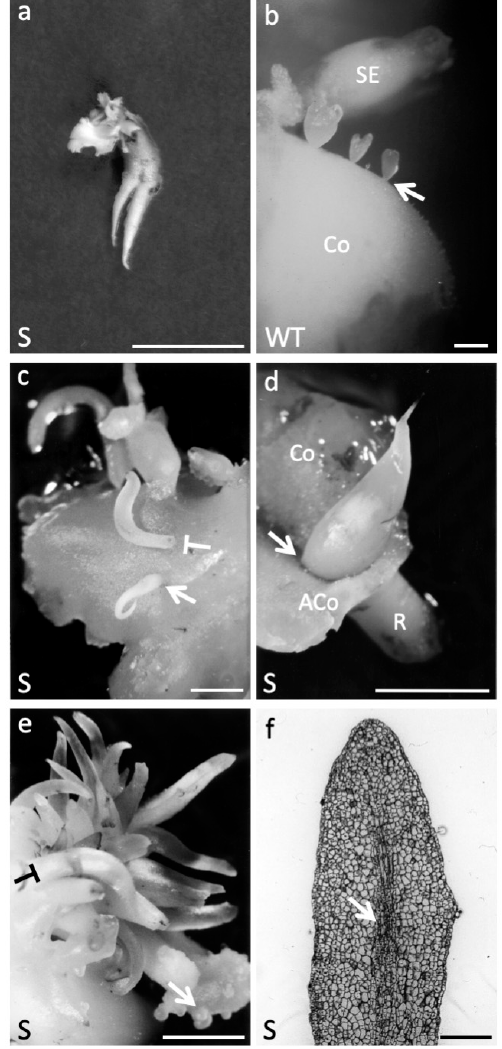
Figure 3. Developmental abnormalities linked to AtAGL12 overexpression in walnut. ( a ) S77 somatic embryo (SE) showing two fused primary roots after 3 weeks of culture. SE presenting fused primary roots were only observed among S embryogenic lines. Scale bar: 1 cm; ( b ) normal repetitive secondary somatic embryogenesis process in wild-type walnut tree I1C line. The picture shows different stages of SE emerging from the cotyledon (Co) of a primary embryo. The arrow points to the thin basal parts of the secondary embryos that develop from single activated epidermal cells. Scale bar: 1mm. ( c ) Ectopic root-like structure (arrow) developing on the apical side of a globular embryo (S77) in place of a regular shoot apex. No cotyledon will form. As in 1b, note the small size of the base of the embryo linked to its single cell origin within the primary cotyledon’s epidermis. When such root-like structures develop directly from activated cells within the epidermal layer, they present a thicker base and need to be cut of the cotyledon in order to be separated from it (T-shaped symbol as in 1e). Scale bar: 0.5 cm; ( d ) root-like structure developing on the apical part of mature S77 somatic embryo. Excision of the cotyledon reveals the base of the structure originating at the cotyledon/shoot apical meristem junction (arrow). Co: cotyledon, ACo: ablated cotyledon, R: embryonic root pole. Scale bar: 1 cm; ( e ) cluster of ectopic root-like structures emerging from activated epidermal cells (S76). Clusters of secondary somatic embryos can be observed on the same initial explant (arrow). Scale bar: 0,5 cm; ( f ) longitudinal section of an ectopic root-like structure (S76). In the central axis of these structures one can observe the initiation of formation of a vascular bundle (arrow) in the absence of a clearly defined apical meristematic zone. Scale bar: 500 µ